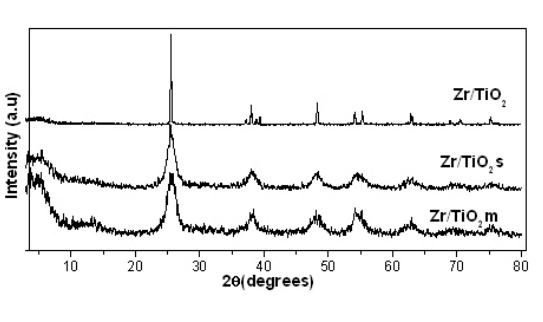
Figure 1. XRD patterns of zirconia doped titania